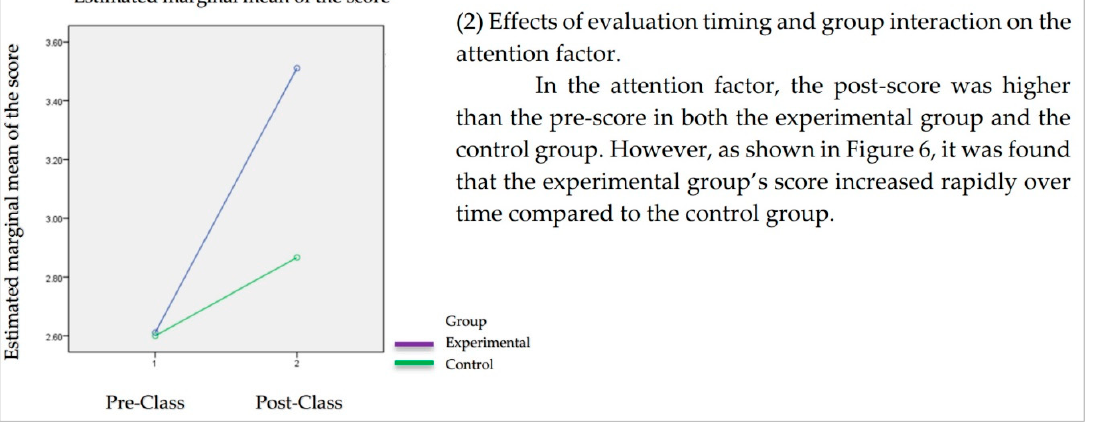
Figure 7. Effect of timing and group interaction on Adequacy. Figure 8. Effect of timing and group interaction on Confidence. 5.2. Results of Analysis of Differences Between Groups of Collaborative Post-Scores In regards to the “Measurement of Collaboration Level,” the experimental group (See Table 13) increased in the (1) joint decision-making (See Figure 9), (2) administrative role (See Figure 10), (3) autonomy (See Figure 11), (4) mutual relations (See Figure 12), (5) trust (See Figure 13), and (6) collaboration results (See Figure14). On the other hand, the control group increased in the post-